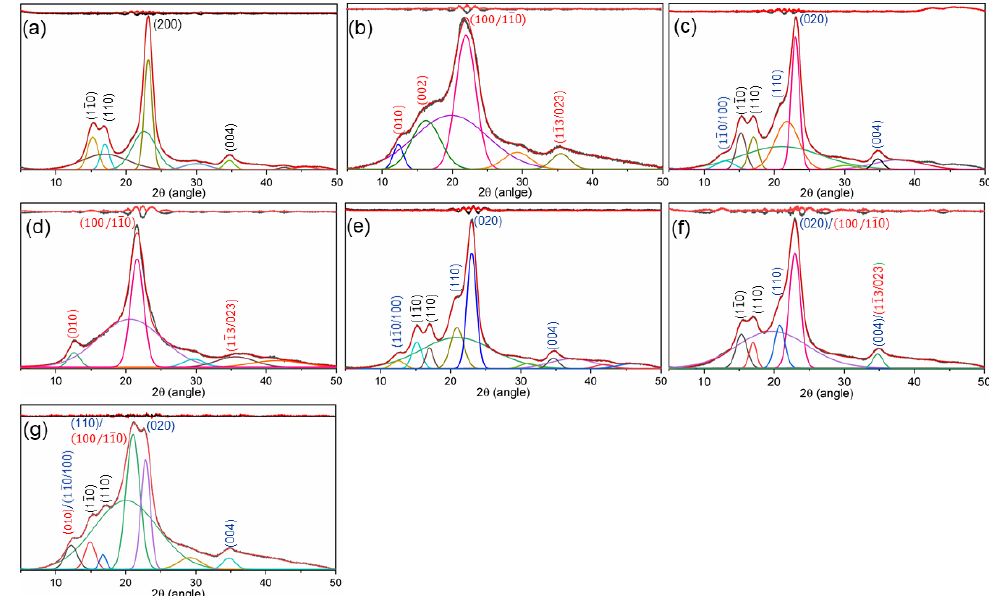
Figure 2. XRD images of the ( a ) original, ( b ) LA, ( c ) CS, ( d ) LA–LA, ( e ) CS–CS, ( f ) LA–CS, and ( g ) CS–LA-mercerized cotton samples.